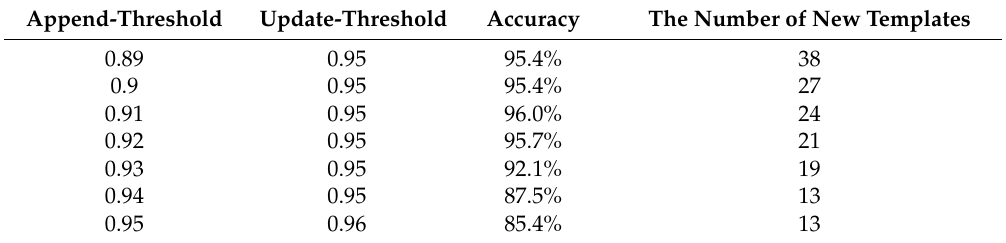
Table 3. Different thresholds for template matching